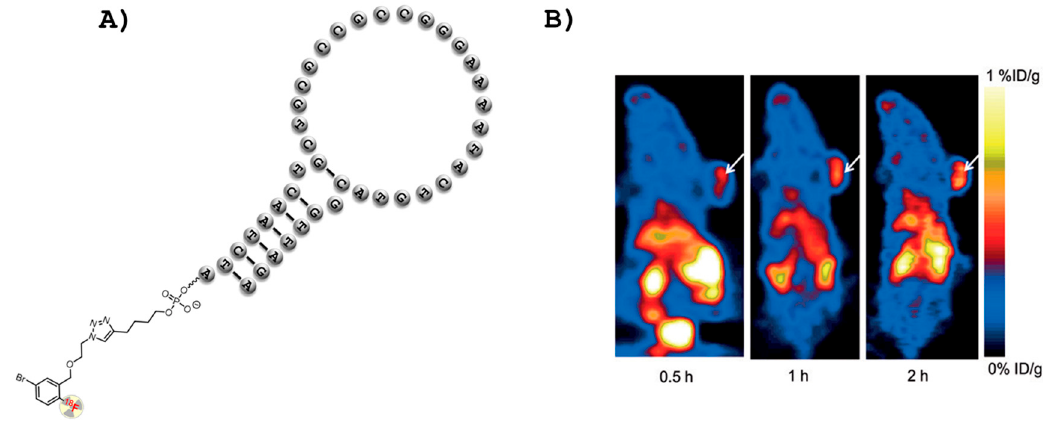
Figure 2. ( A ) Hypothetical secondary structure of the sgc8 aptamer and the 18 F-label; and ( B ) positron emission tomography (PET) images of a mouse model with HCT116 tumors, white arrows represent the HCT116 xenograft [65].